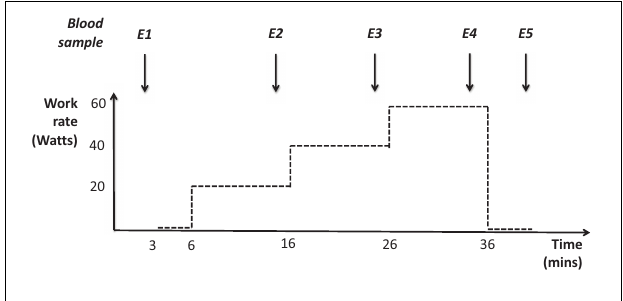
FIGURE 1 | Profile of submaximal constant work rate exercise tests (performed at both sea level and high altitude) and the five time points where plasma was collected during these tests: the beginning of the test (E1), 2 min before the end of the 20 W, 40 W, and 60 W stages (E2, E3, and E4, respectively) and immediately before finishing the test during unloaded recovery